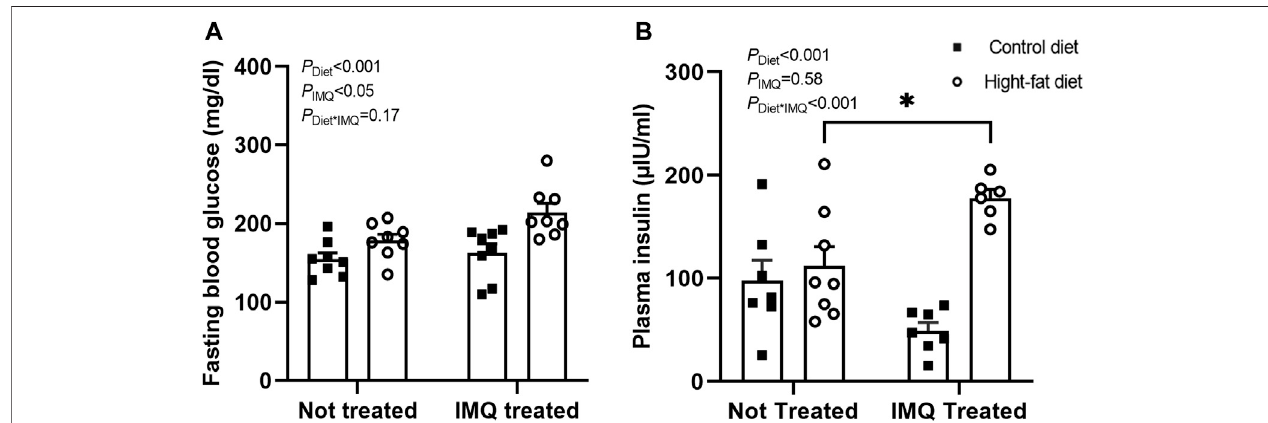
FIGURE2| Imiquimod impairs glucose homeostasis. (A) Conscious fasting blood glucose after 6 weeksoftreatmentwas signi fi cantlyelevated inhigh-fat dietand IMQ-treatedgroups. (B) IMQaffectedfasted plasmainsulinconcentrationinadiet-dependentmanner,withhyperinsulinemiaobservedonlyinIMQ-treated miceonafat diet(* p < 0.05byBonferronipost-hoctest).Statisticalcomparisonsareindicatedin Figure1 .Dataareshownforn=6-8pergroupduetoinsuf fi cientplasmaavailablefor some